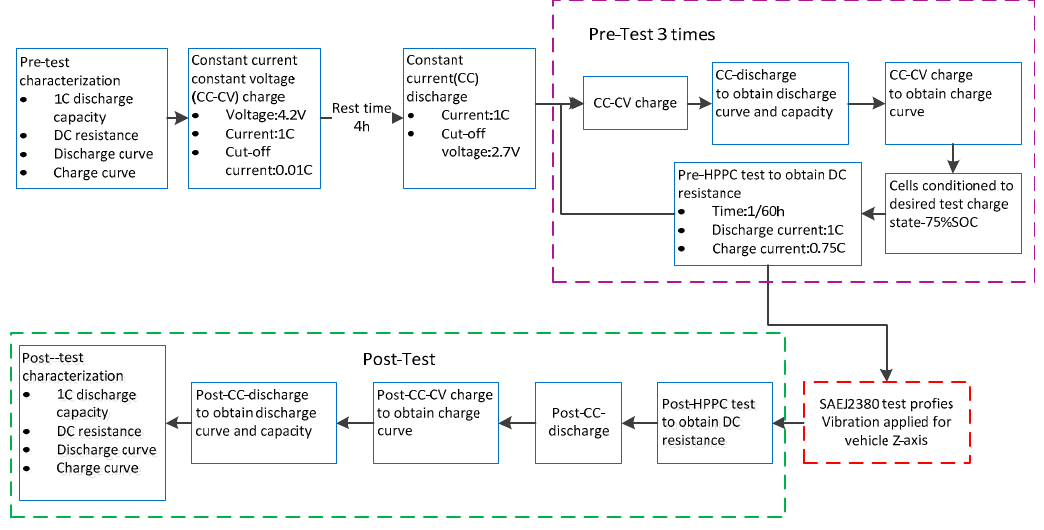
Figure 2. Schematic of electrical performance test process.